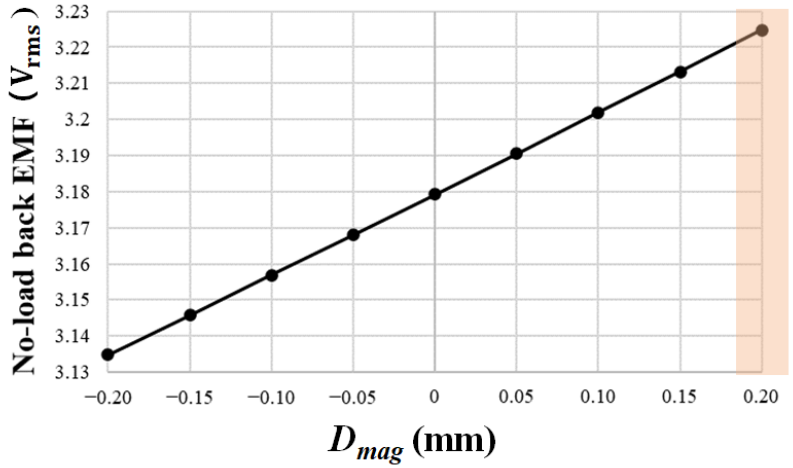
Figure 10. No-load back EMF variation with D mag (4000 rpm).